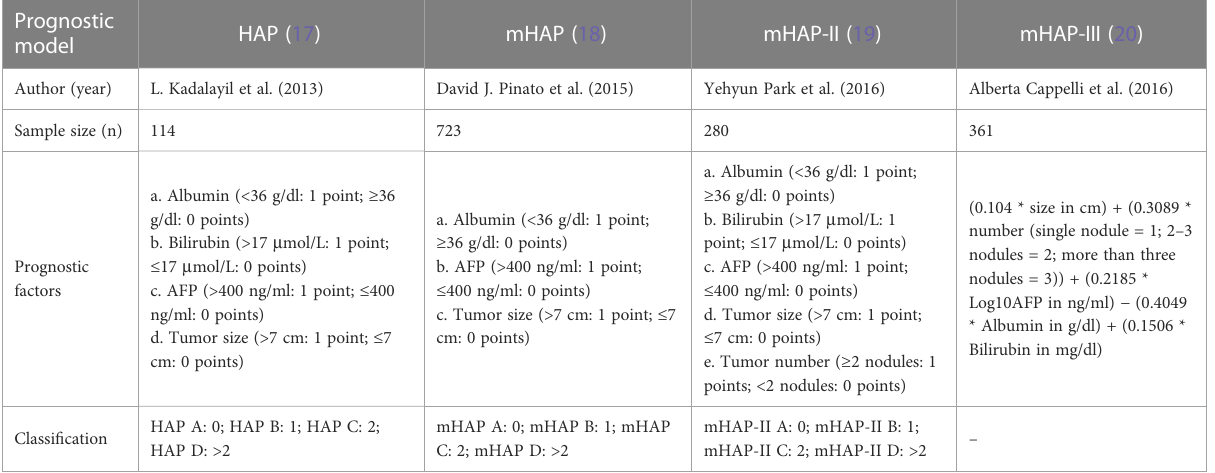
TABLE 1 HAP serial score